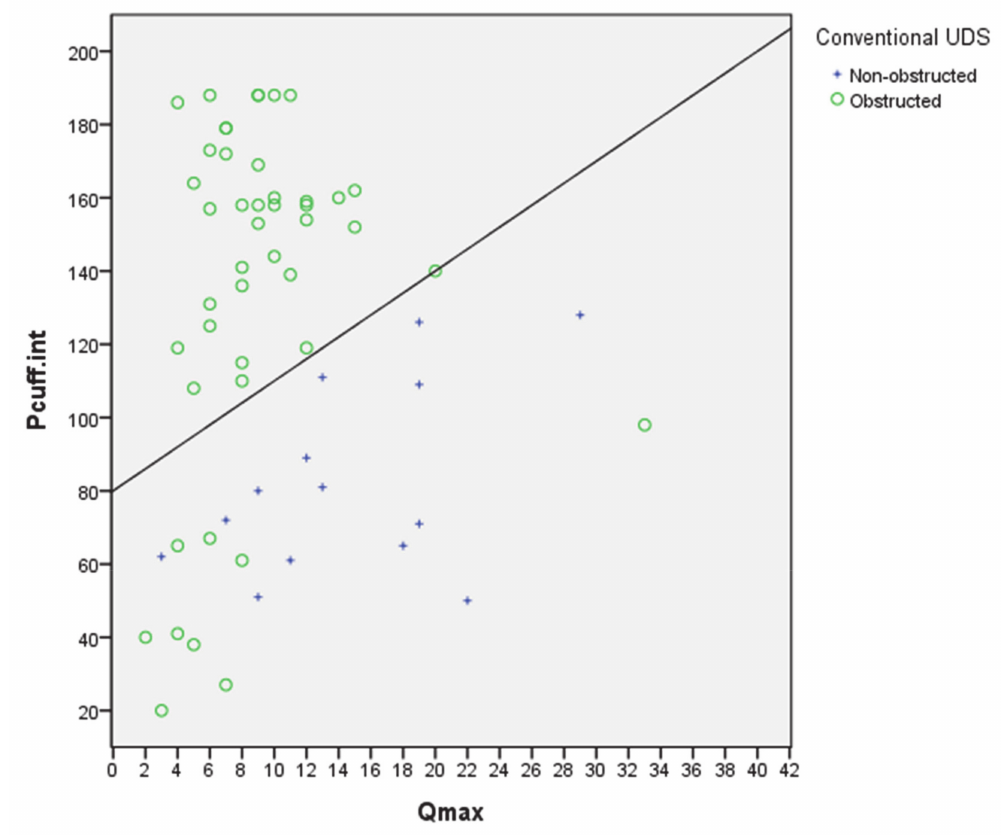
Figure 1. Modified nomogram with data from 59 patients showing the classifications by conventional UDS using the International Continence Society (ICS) nomogram.